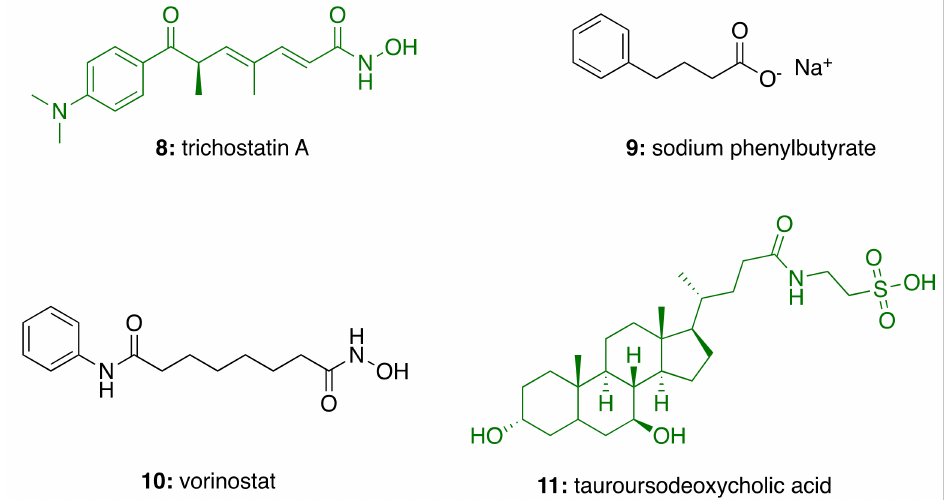
Figure 2. Structures of natural product (in green) and natural product-derived and synthetic (in black) anti-Alzheimer’s